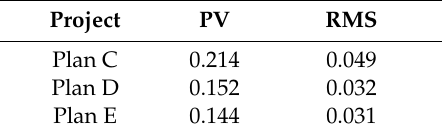
Table 4. Peak-to-valley (PV) and root mean square (RMS) of wavefront aberration under di ff erent